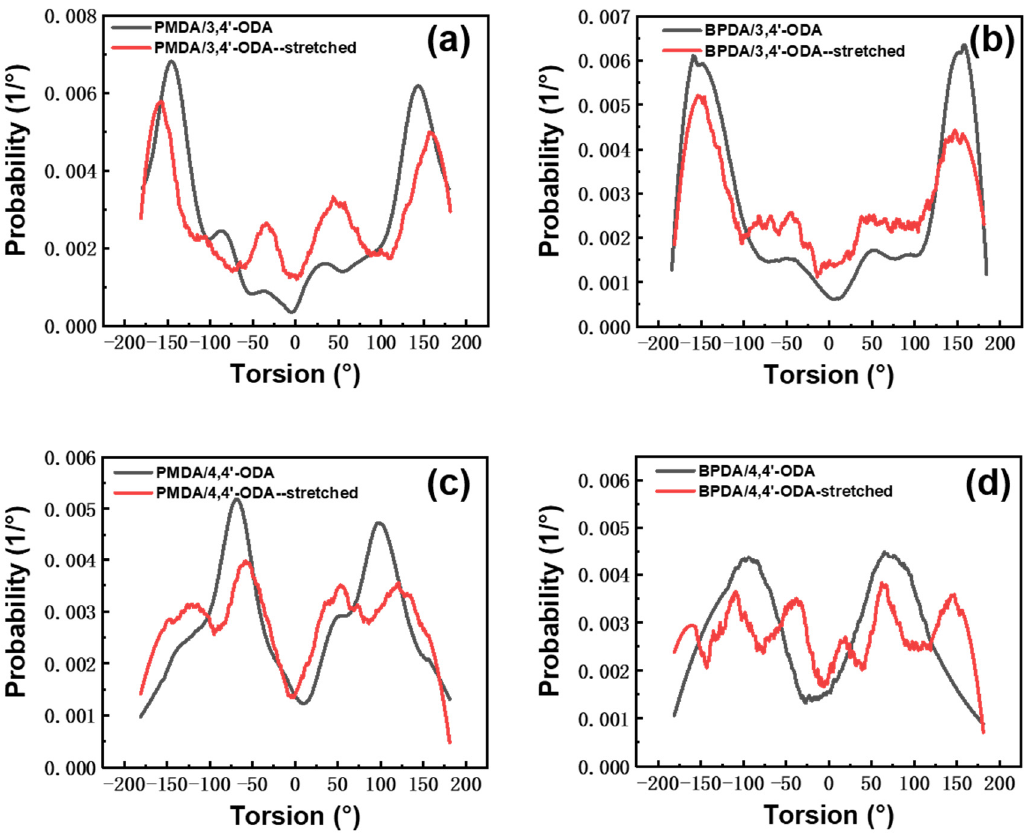
Figure 9. Torsion angles analysis of different systems of PI. ( a ) PMDA/3,4 ′ -ODA; ( b ) BPDA/3,4 ′ -ODA; ( c ) PMDA/4,4 ′ -ODA; ( d ) BPDA/4,4 ′ -ODA.